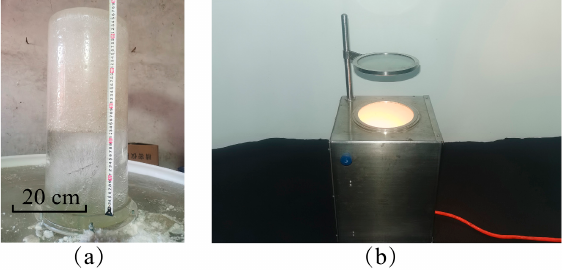
Figure 4. Observation of frazil ice crystal microstructure: ( a ) the original ice block; ( b ) universal stage for ice slice observation.